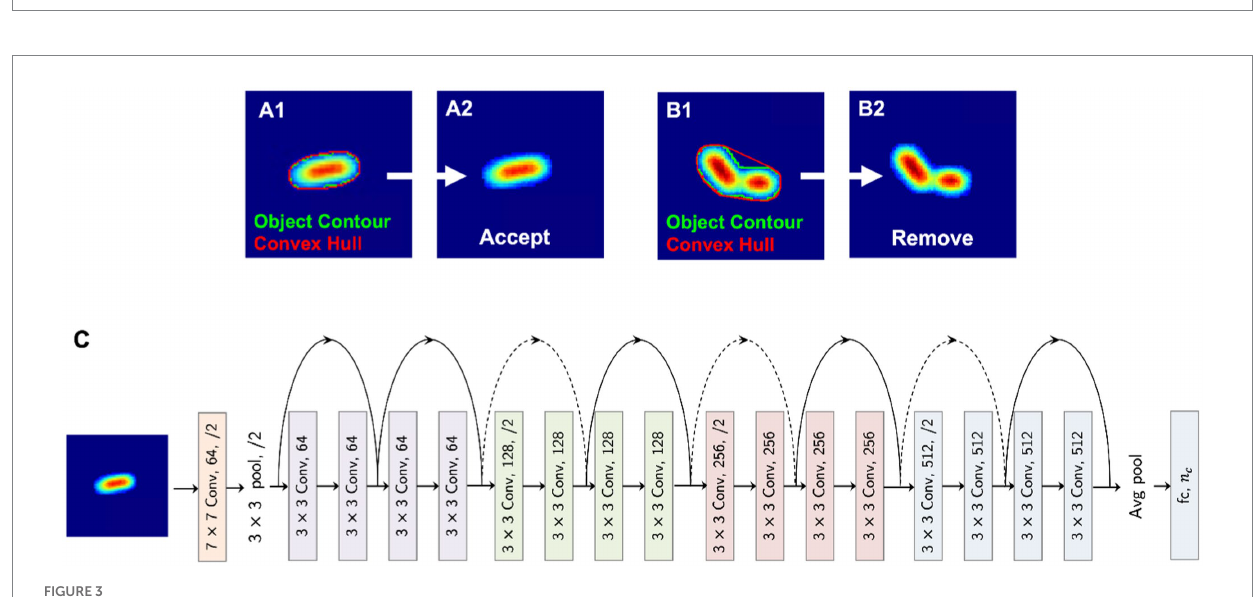
FIGURE 3 Deep neural network pipeline. (A,B) A heuristic for detecting co-located bacteria. (C) Neural network